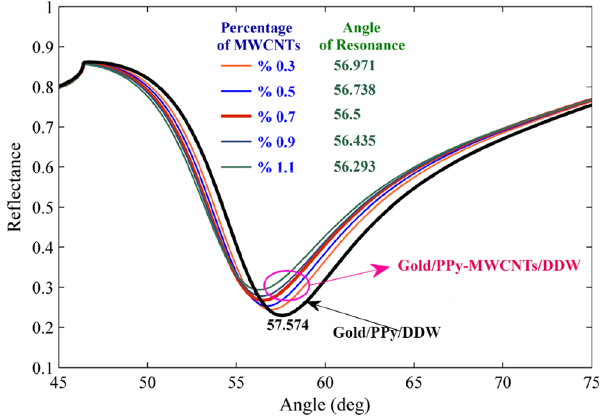
Figure 2. The SPR signals for different percentages of MWCNTs are used to measure the real and imaginary parts of a refractive index. The SPR signal for gold/PPy-MWCNTs/DDW and gold/PPy/DDW are the baseline signals used to obtain the angle shift after using the sensor for the detection of ions by minimizing the Eq. (1).